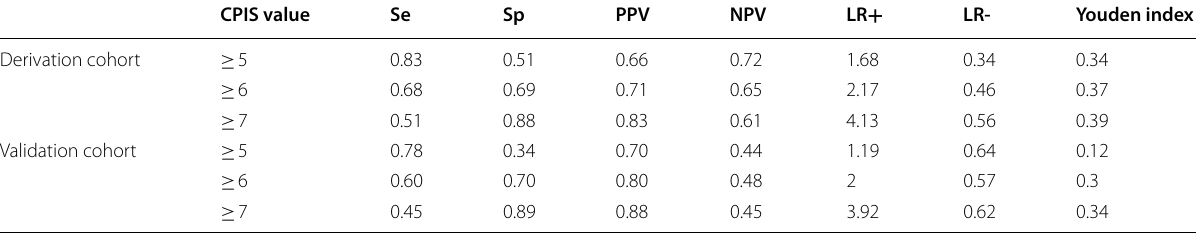
Positive likelihood ratio, LR - +